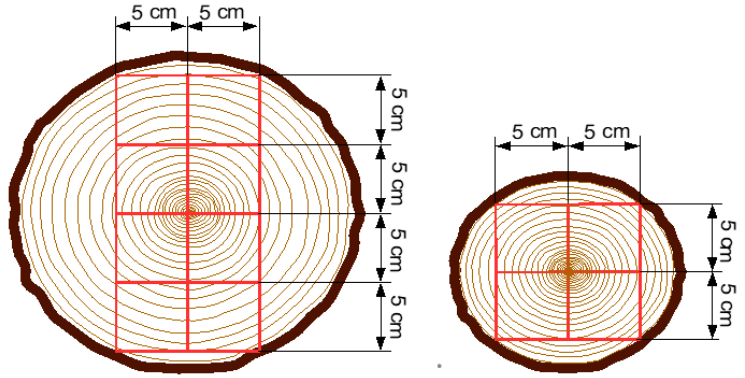
Figure 1. Schematic drawing of the sample preparation: approximately 4 to 8 samples were prepared from each log, depending on log diameter.